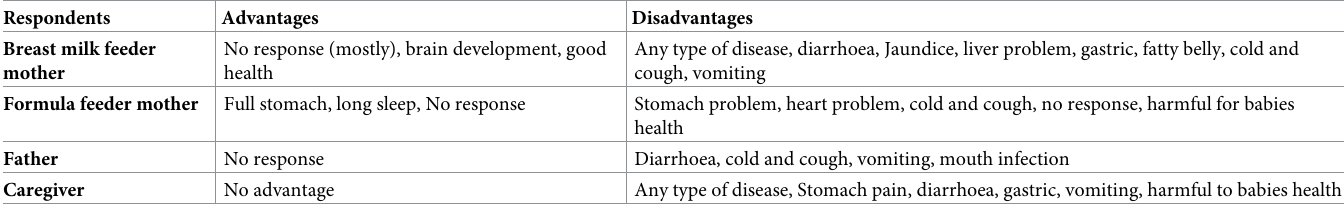
Table 4. Respondents perception on infant